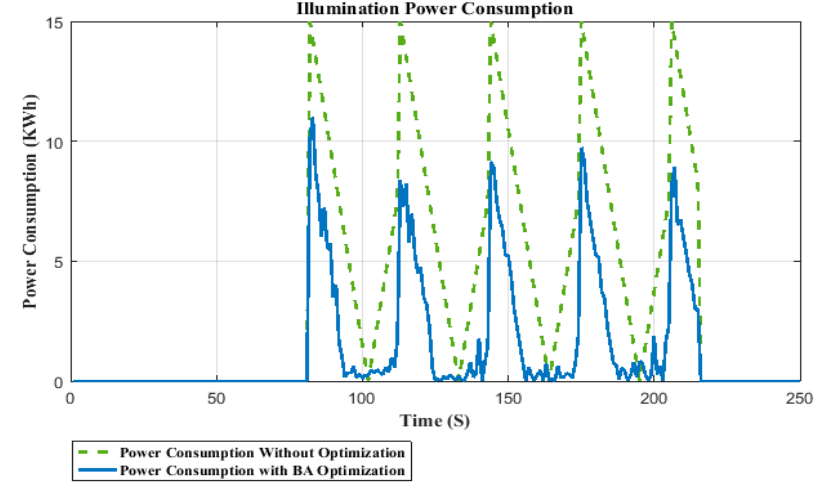
Figure. 14. Power consumption for illumination with BA optimization and without BA optimization.